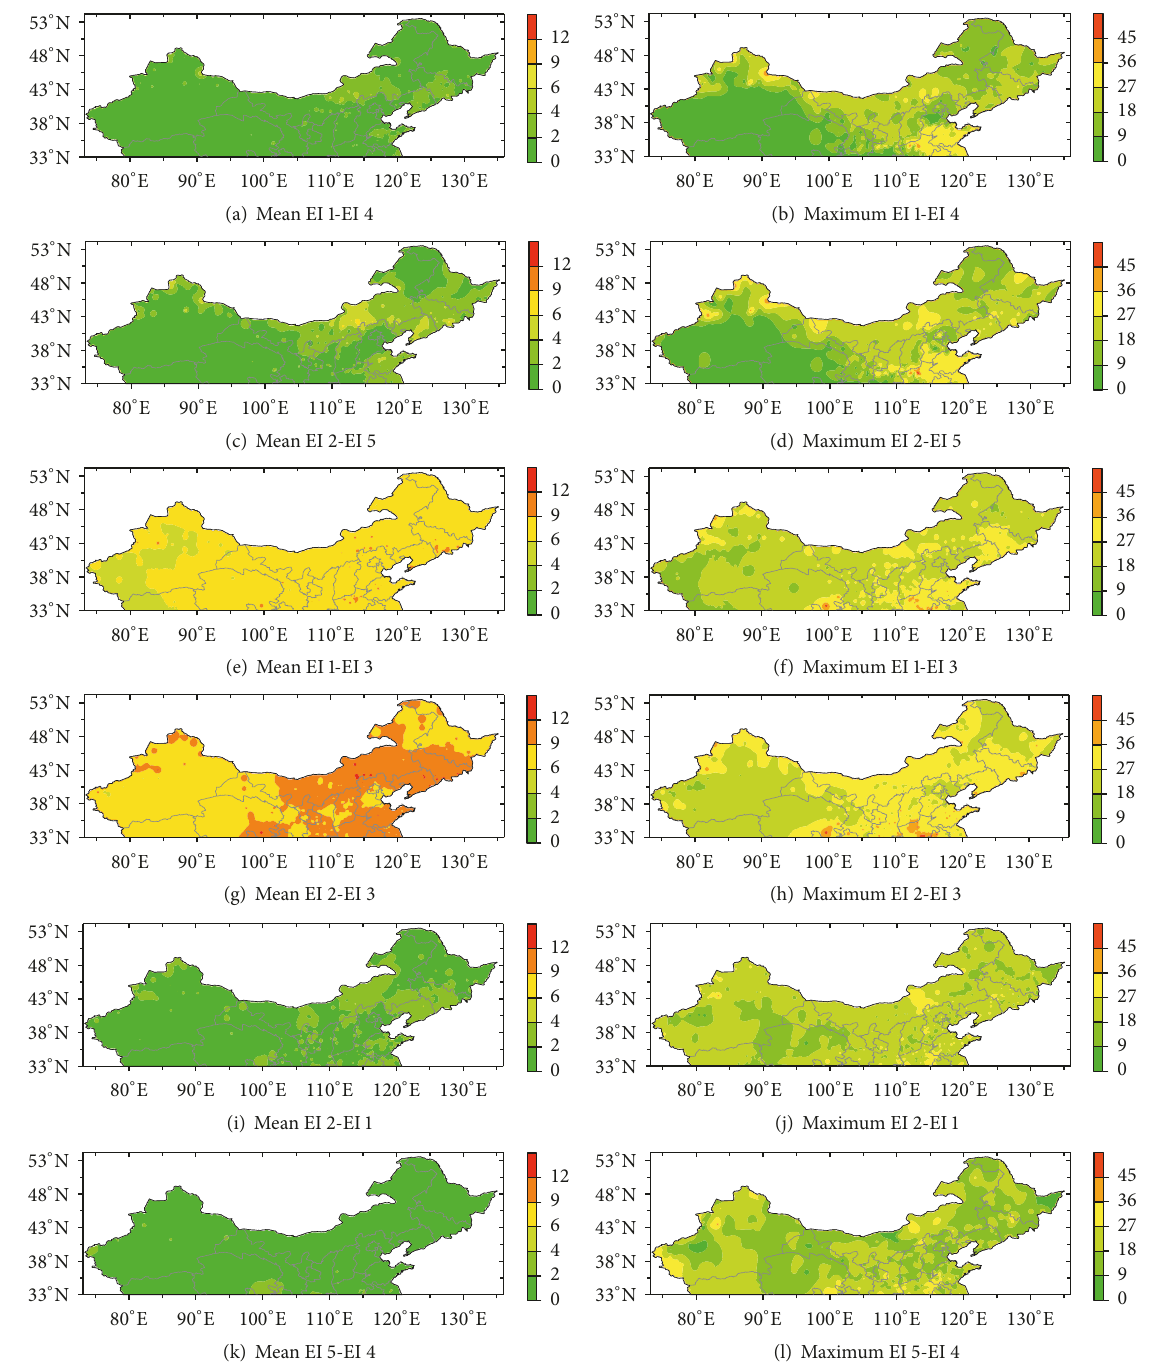
Figure 5: Differences (days) in the end of the growing season between selected indices in northern China. Shown are the mean values ((a), (c), (e), (g), (i), and (k)) and maximum values ((b), (d), (f), (h), (j), and (l)).